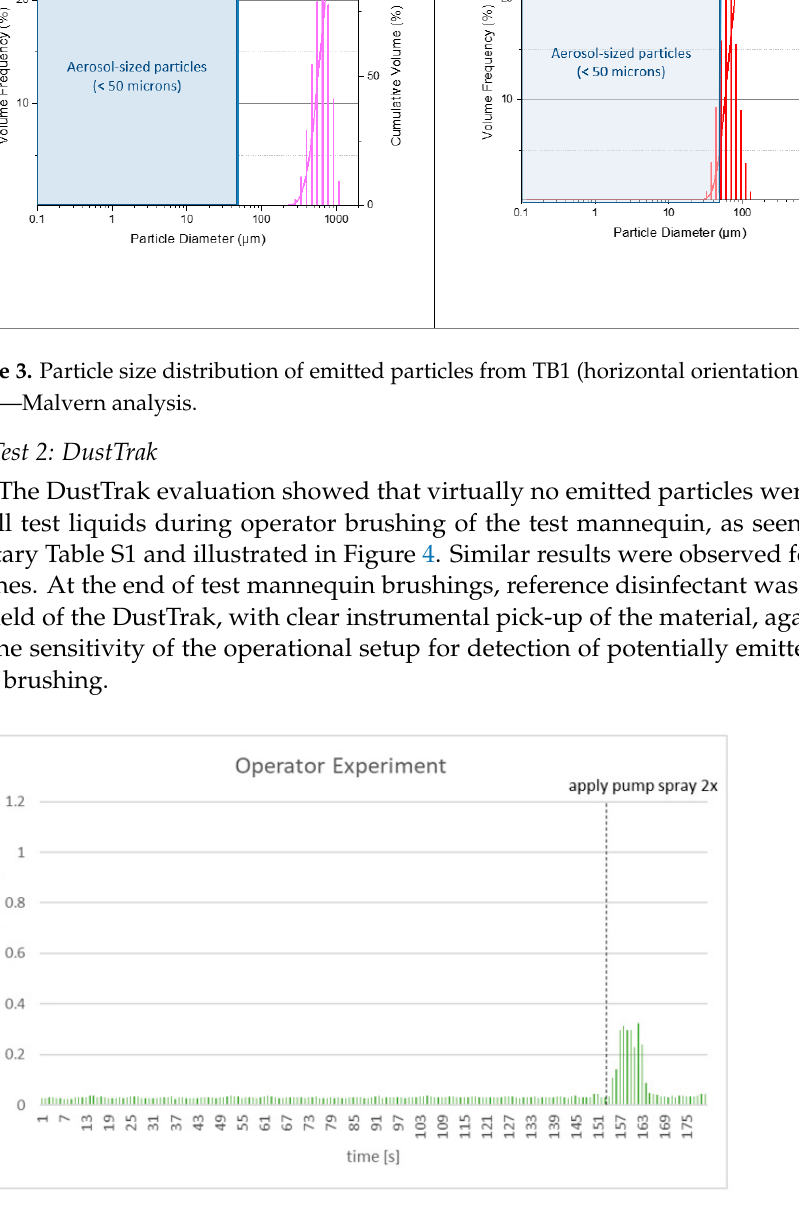
Figure 4. DustTrak measurements of particles generated at operator’s distance when brushing a mannequin’s oral cavity (see Figure 2D) for 2 min with a slurry and then applying the reference